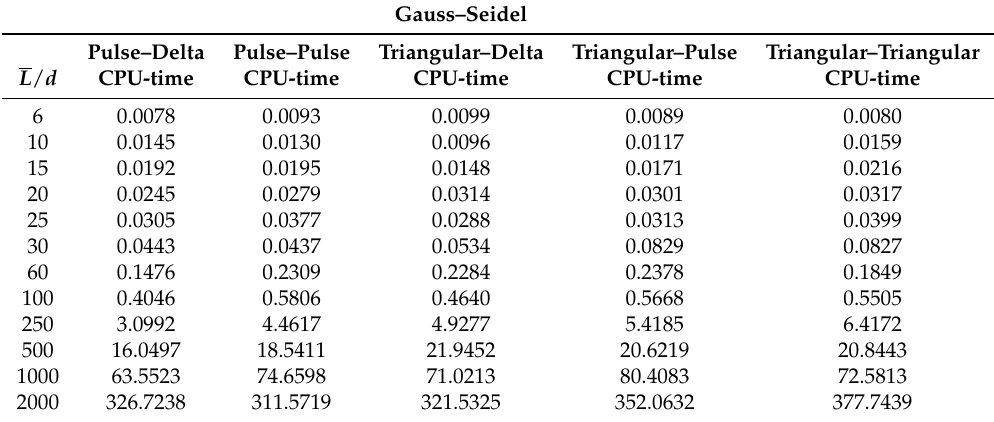
Table 7. Gauss–Seidel: CPU-time (s) and number of iterations for each pair basis-testing functions as L changes. d